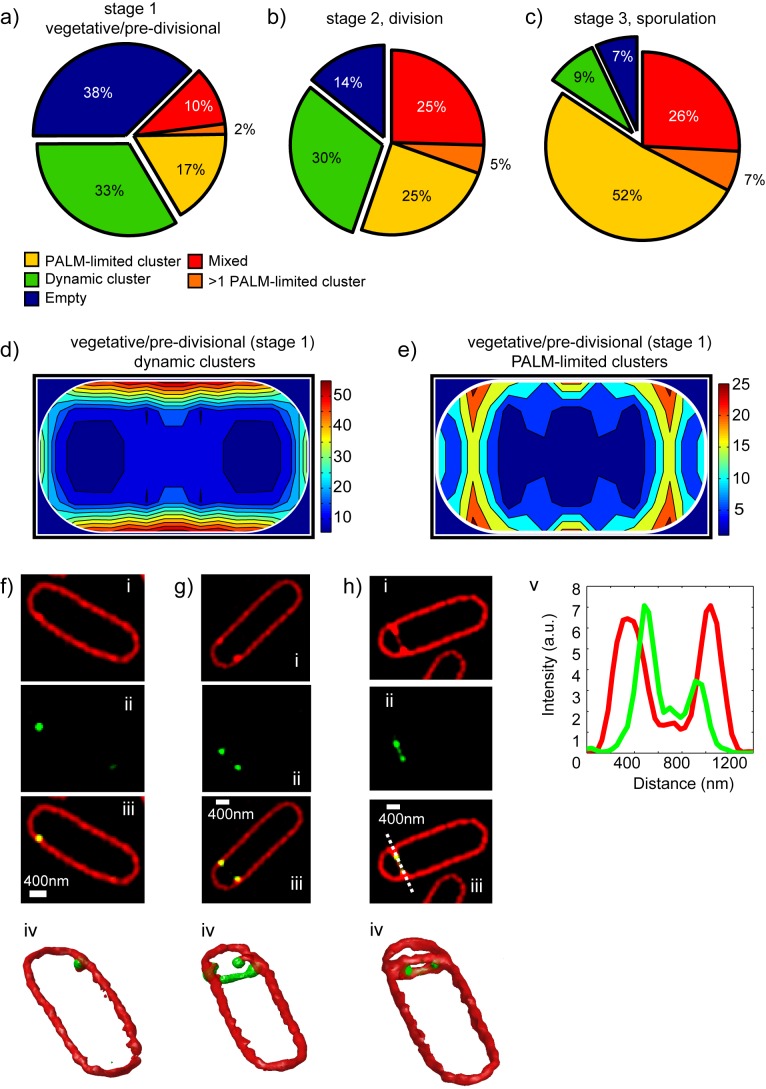
SpoIIIE is recruited to future sites of septation and localizes to the leading edge of closing septa.(a–c) Statistics of SpoIIIE clusters in vegetative/pre-divisional (N = 705), dividing (N = 174), and sporulating (N = 2 13) cells. Clusters were automatically classified as dynamic, PALM-limited, or mixed (cells containing both cluster types). Cells with less than 50 detected events were classified as “empty.” Cells with more than one PALM-limited cluster were classified independently from those containing a single one. The proportion of single PALM-limited clusters increases from vegetative/pre-divisional to dividing cells, and is maximal in sporulating cells. (d–e) The normalized coordinates of each localized event (axial and longitudinal coordinates) were used to calculate the localization probability distribution (heat maps) of SpoIIIE for each cluster type in vegetative/pre-divisional cells. Normalized localization probability distributions were calculated for the first quartile of the cell and then reflected into the other three quartiles to impose mirror symmetry in the axis perpendicular and parallel to the cell axis. The relative average number of clusters detected in each pixel of the grid is color-coded according to the color bar (right). White lines represent cells outlines. (d) Dynamic clusters distribute homogeneously over the cell membrane. (e) In contrast, in cells in which sporulation was induced, PALM-limited clusters specifically localize to future sites of asymmetric septation. (f–h) 3D-SIM imaging of B. subtilis cells in the early phases of sporulation at different stages of septal constriction. Axial projections showing the distribution of FM4-64-stained membranes (red, i), fluorescently labeled SpoIIIE (ii), and a merged image (iii). A 3D reconstruction is obtained by calculating a constant fluorescence intensity profile (iv). (f) SpoIIIE localizes to future sites of asymmetric division before the onset of septal constriction as a single cluster with a size <100 nm (resolution limit in 3D-SIM). (g) In cells early in septal constriction, SpoIIIE often shows a ring-like distribution probably due to the intrinsic dynamics of the closing septal ring. (h) In cells advanced in septum constriction, SpoIIIE specifically localizes to the leading edge of the invaginating septum. A line scan (v) of the fluorescence signal across the closing septum (white dotted line in panel iii) shows that SpoIIIE fluorescence (green) is always internal to the fluorescence of the membrane (red). Scale bar, 400 nm.